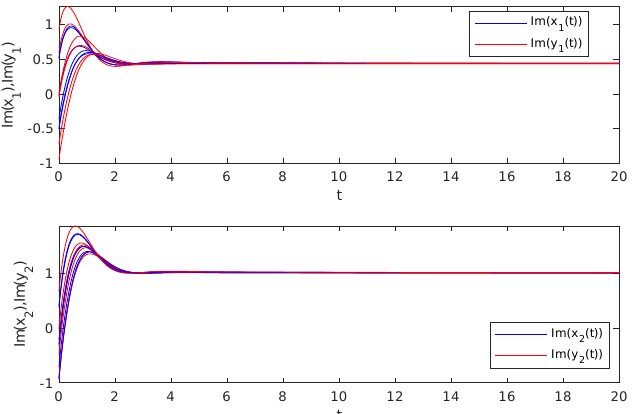
Figure 1. Dynamic evolution of the real part of the FCINN (26) with I 1 = 2 + 2 i and I 2 = 5 + 4 i .